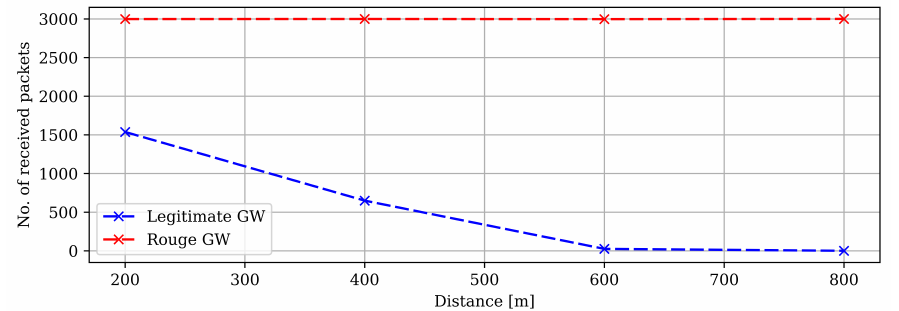
Figure 11. Preliminary testing area with no line of sight. R-GW permanently placed at 200 m from the ED and L-GW placed at 200 m increments up to 800